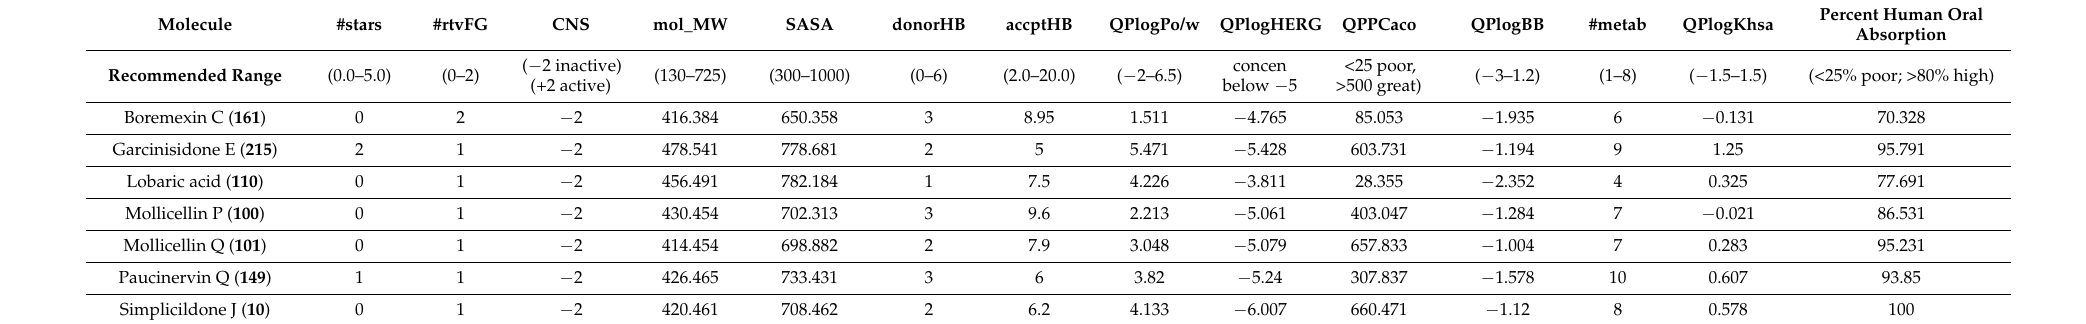
Table 3. In silico ADME properties of tested depsidone